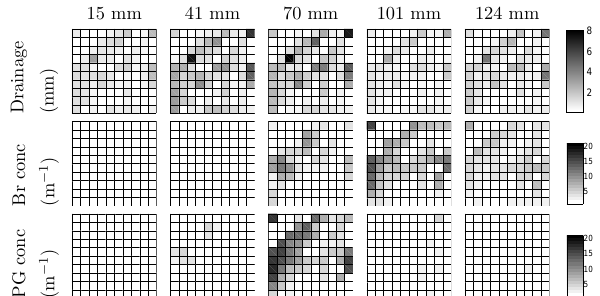
Fig. 5. Spatial distributions of the drainage, the bromide concen- tration, and the PG concentration during the irrigation experiment over the multi-compartment sampler consisting of 10 × 10 cells of 3 . 15 × 3 . 15cm 2 each. The concentrations of bromide and PG are scaled with the applied mass per m 2 . The titles refer to the cumula- tive drainage since solute